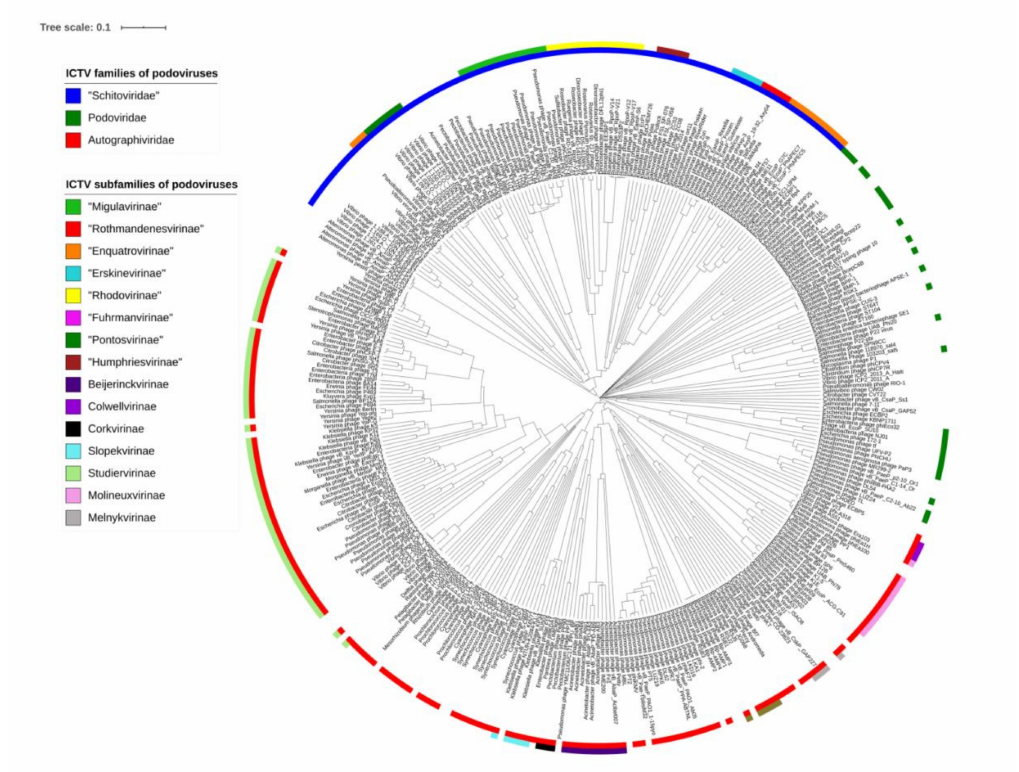
Figure 2. ViPTree analysis of N4-like viruses with related podoviruses. Results were visualized with iTol. Viruses were assigned and marked according to the o ffi cial ICTV classification with the outer and inner rings representing classification at the subfamily and family level, respectively. Non-marked viruses have not been classified